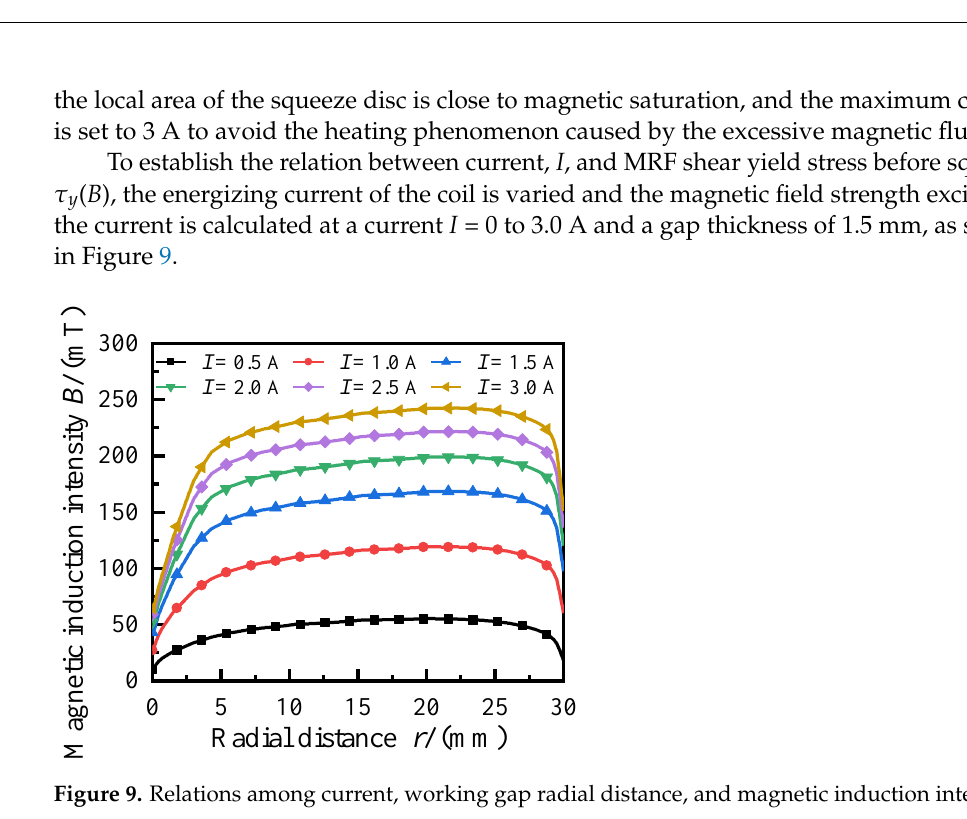
Figure 9. Relations among current, working gap radial distance, and magnetic induction intensity. The radial distance from any plane of the MRF to the small diameter is defined as r .